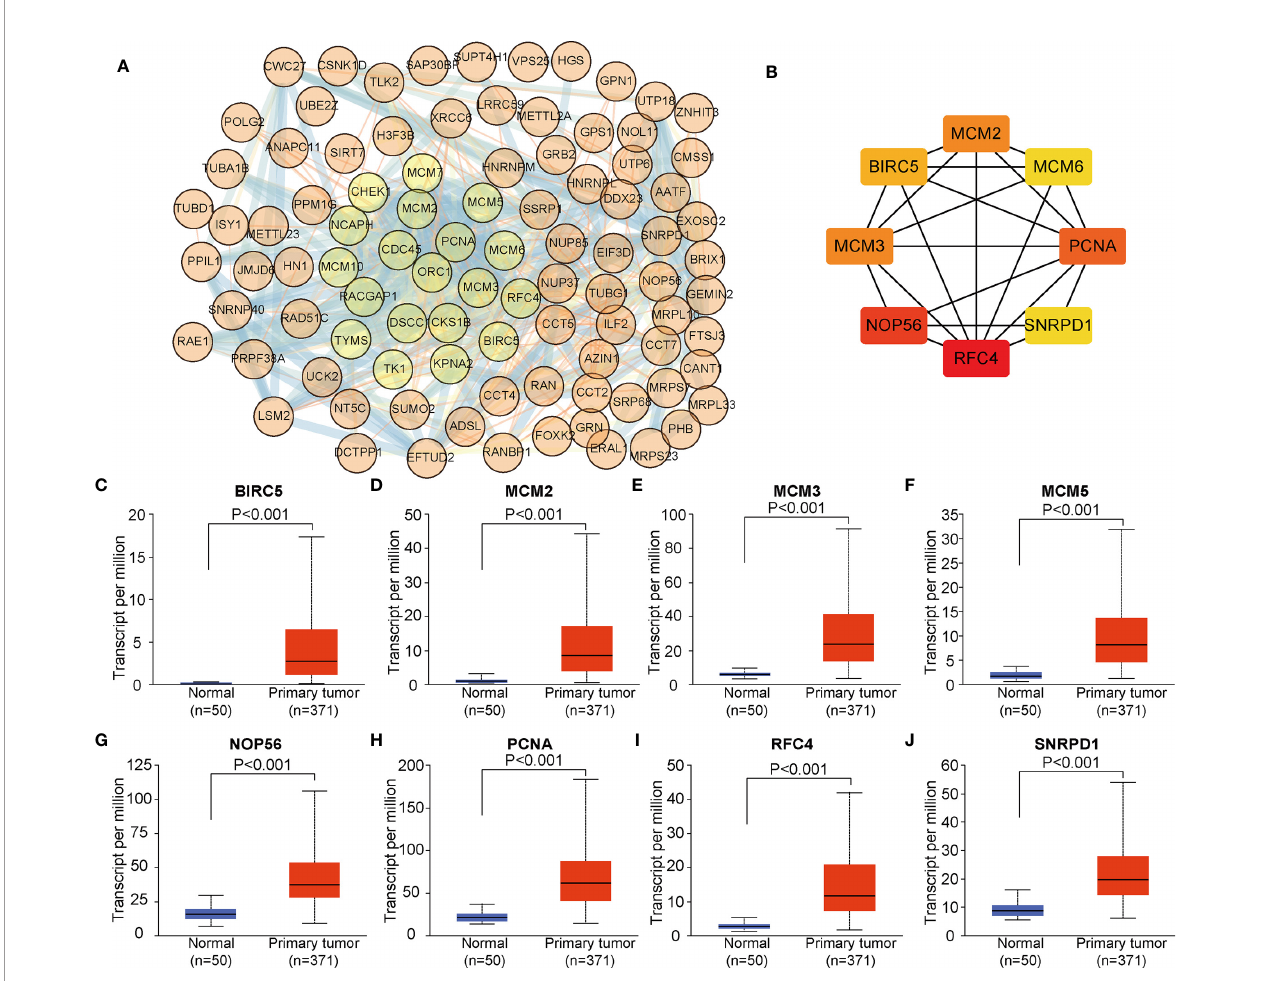
FIGURE 6 | Identi fi cation of co-related hub genes for ALYREF and eIF4A3. (A) The protein-protein interaction network for the 104 co-related differentially expressed genes between ALYREF and eIF4A3. (B) In total, eight co-related hub genes were identi fi ed for ALYREF and eIF4A3. (C – J) . The expression levels of these hub genes in primary liver cancer samples and in normal samples. Hub gene expressions were elevated in tumor tissues compared to normal tissues.